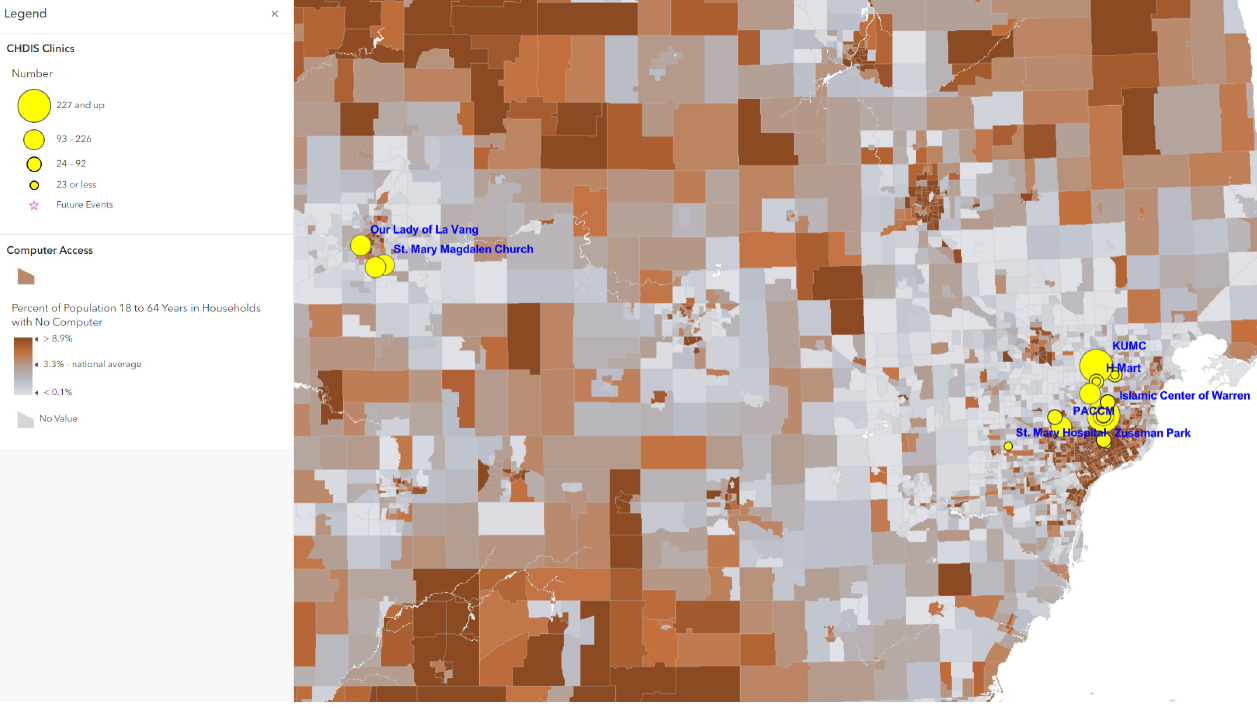
Figure 5. EMU mobile clinics vs. percent of population 18 to 64 years in households with no com- puter.